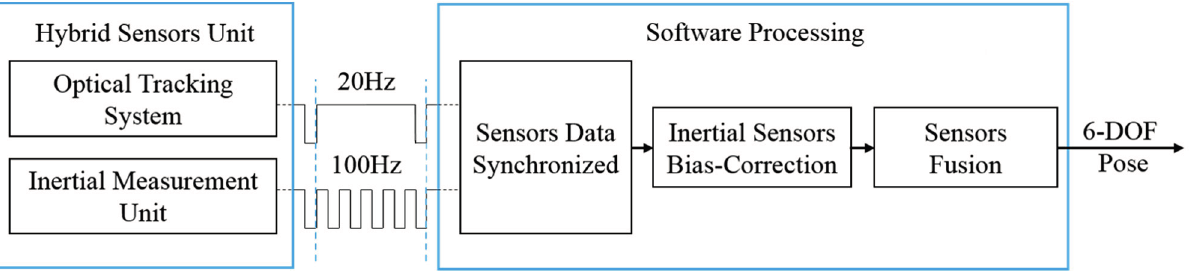
Figure 3. Workflow of the hybrid tracking system.